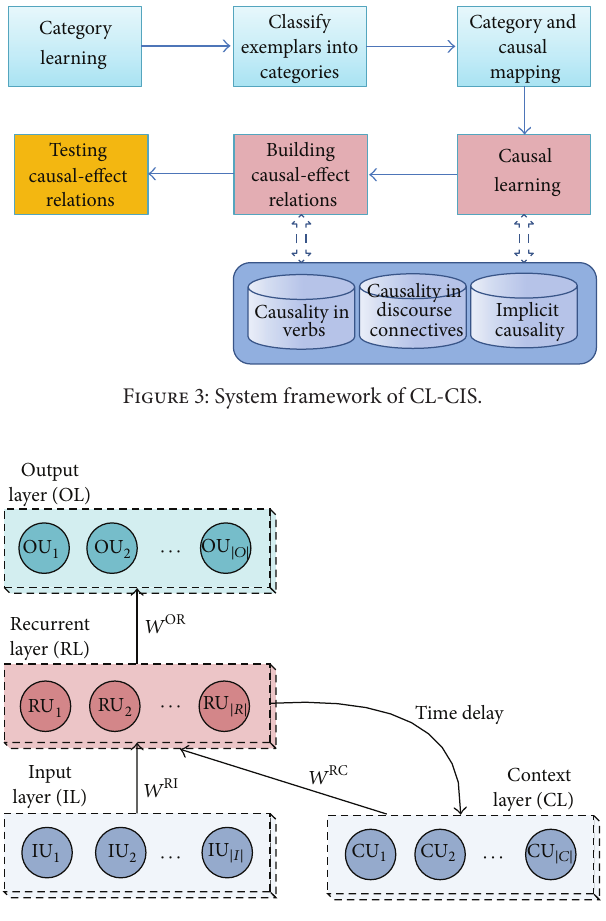
Table 3: Exemplar implicit causality verbs.